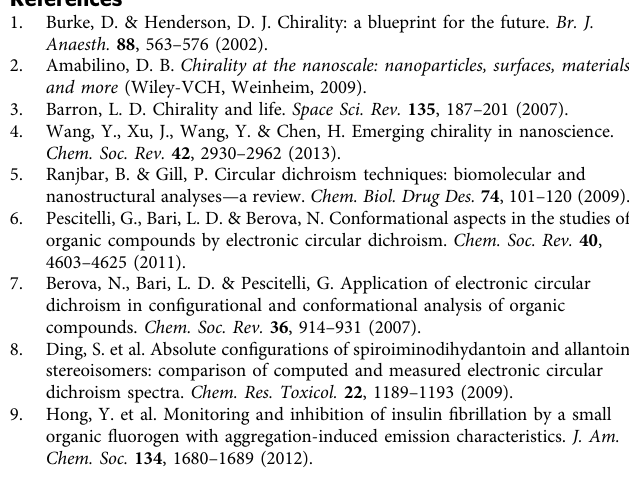
Fig. 9 Photoluminescence spectra. a P- 1 and b P- 2 in THF/water mixtures with different water fractions ( f w ). Concentration: 10 − 5 M. λ ex = 355nm. c Plots of α f α = I / I I = maximum emission intensity at f AIE versus w , where AIE 0 and 0 under UV illumination. d Plots of λ em – ( λ em ) 0 versus different f w . λ em : emission maximum of each plot, ( λ em ) 0 : maximum emission wavelength at f w =